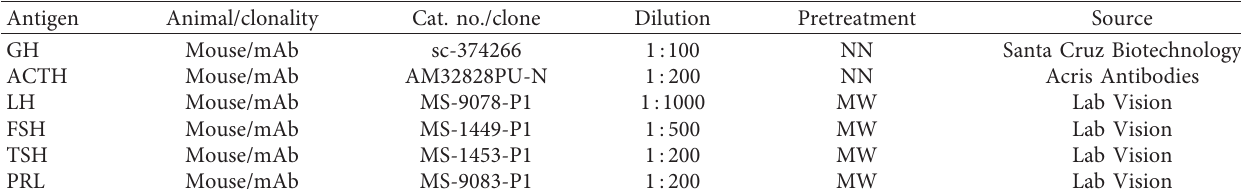
Table 1: Primary antibodies used in immunohistochemistry of anterior pituitary hormones.